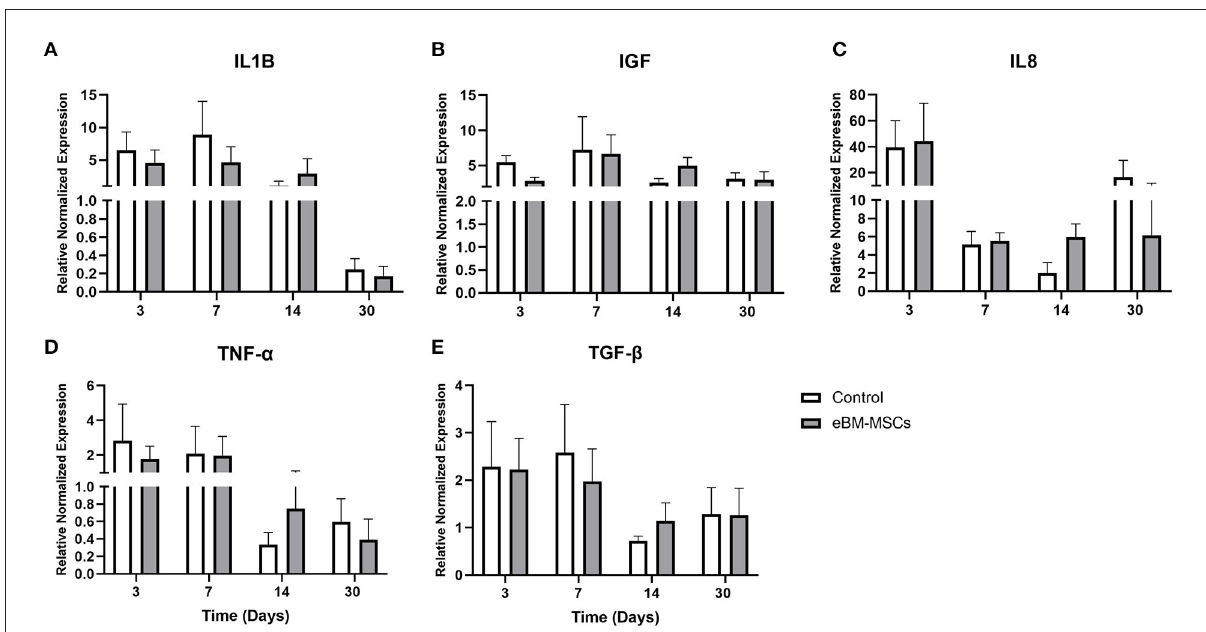
FIGURE4 Real time PCR of the pro- and anti-inflammatory markers. The expression profiles of IL β (A) , IGF (B) , IL8 (C) , TNF α (D) and TGF β (E) were generated at days 3, 7, 15 and 30 post therapy. Changes in expression for each mRNA was normalized with the Ct values obtained for 18S RNA and are plotted as Delta Ct in arbitrary units (AU). P < 0.05 was set as